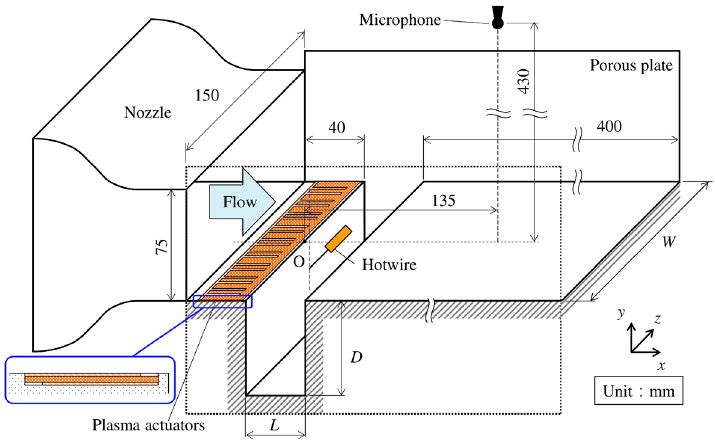
Figure 3. Experimental setup for the measurement of control effects on cavity flow and tone.